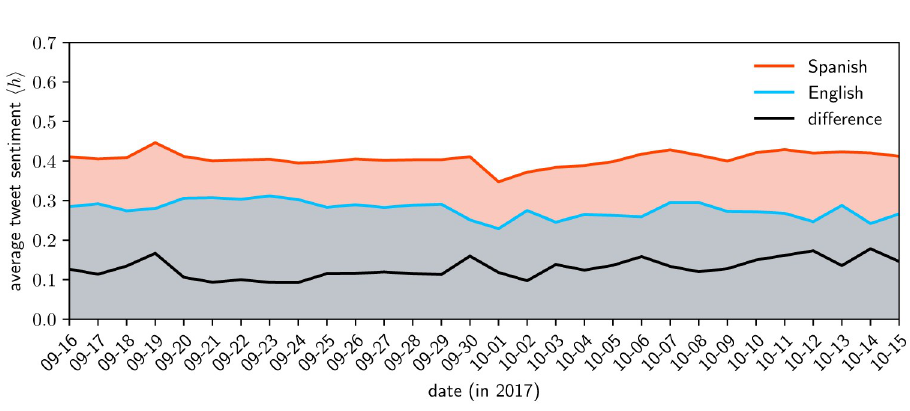
Fig 3. The daily average happiness of Spanish and English tweets in our collected subset of Twitter’s Decahose sample. The difference between the average happiness for each day is shown by the solid black line. Spanish tweets are more positive than English tweets throughout the time period, likely due to the underlying word scores. In previous work studying 10 major languages Dodds et al. found Spanish to be the language containing the highest proportion of happy words